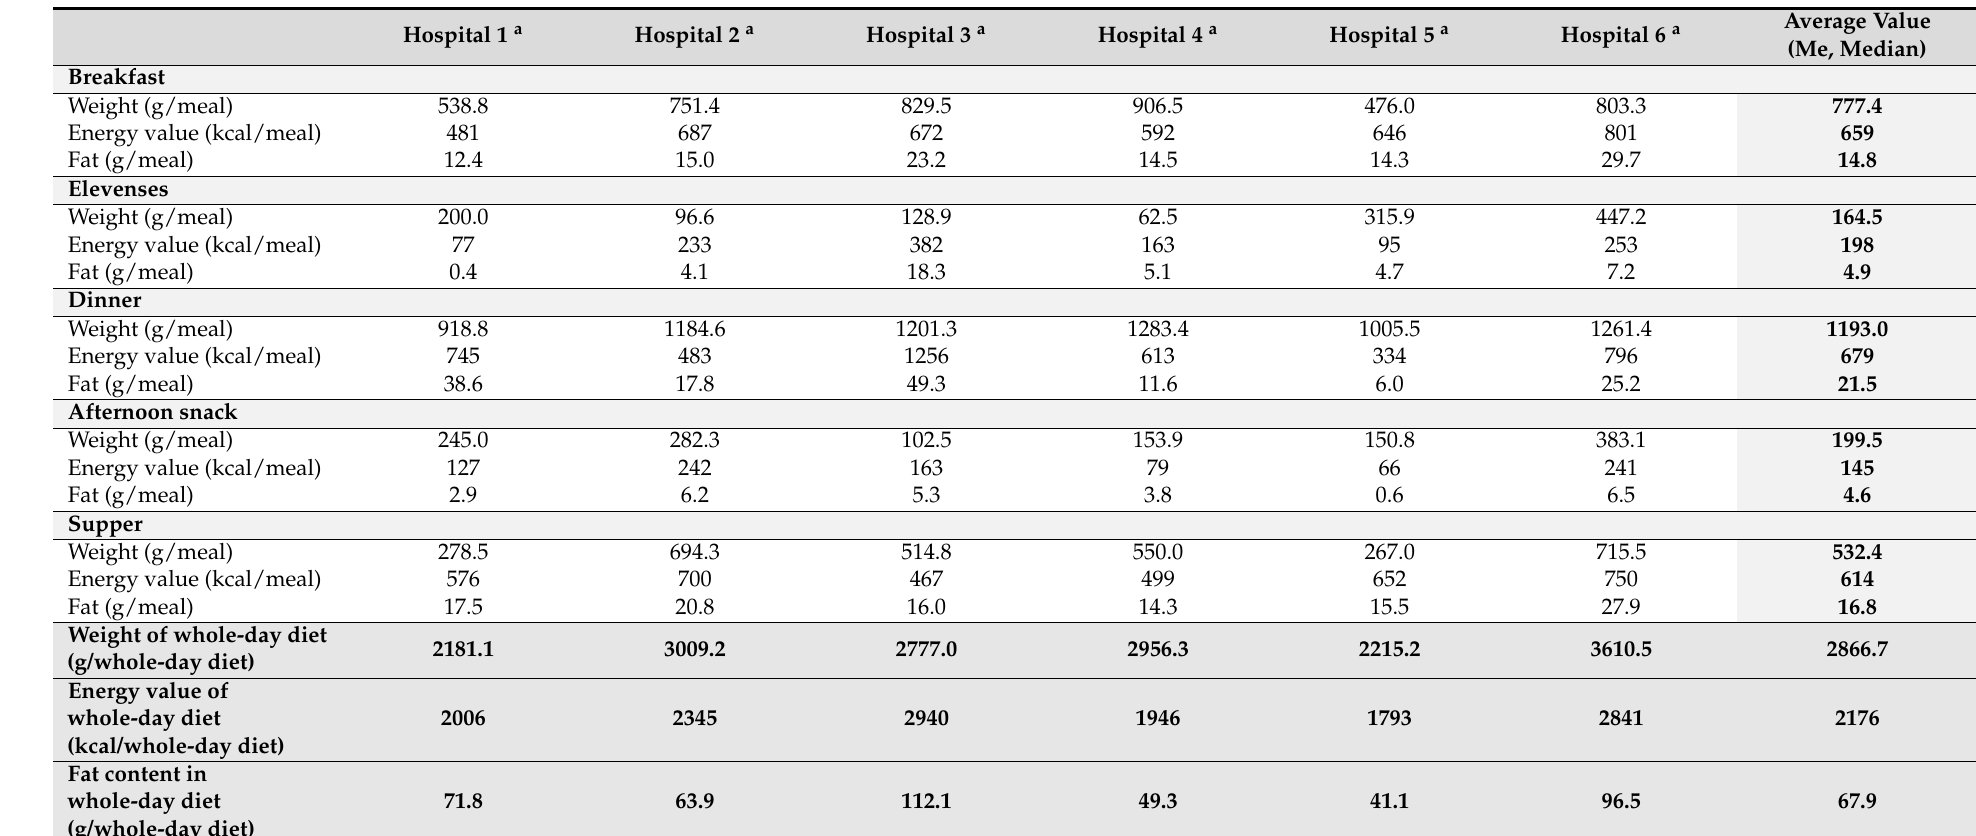
Table 1. Comparison of the selected parameters of the individual meals and whole-day hospital